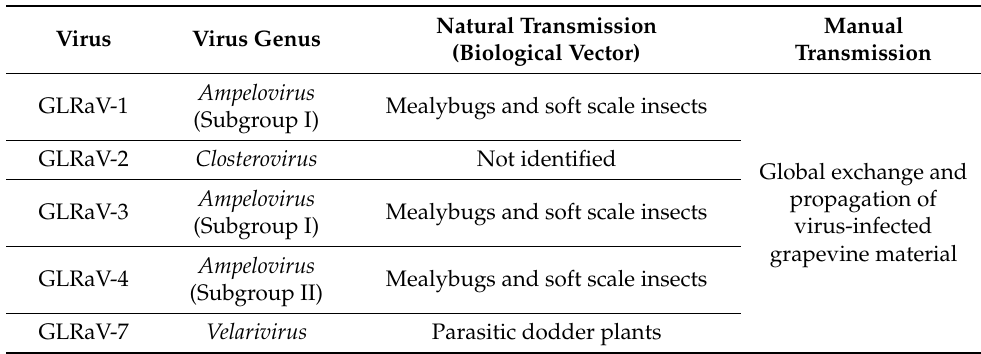
Table 1. Summary of transmission routes of